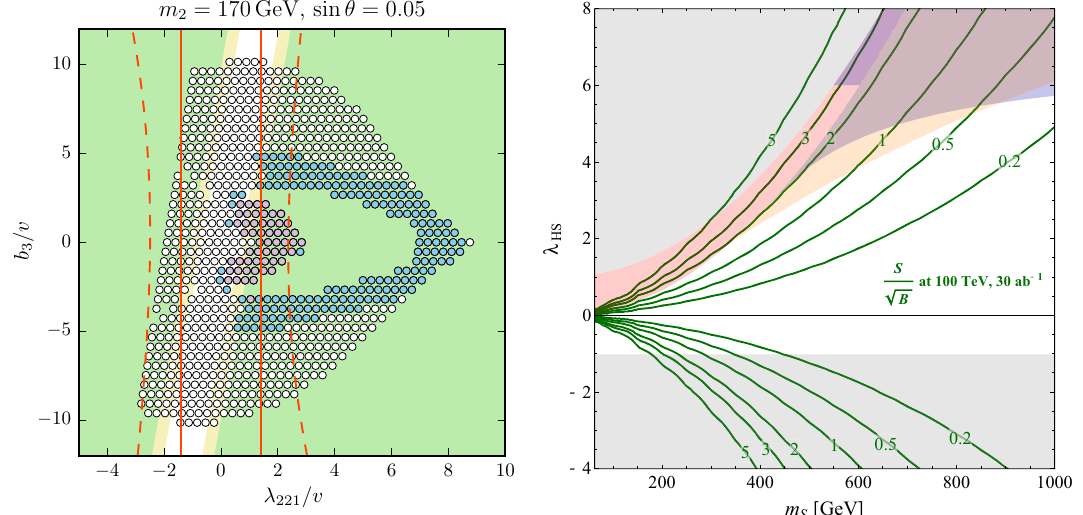
Fig. 11.2 Singlet-like scalar pair production as a signature of the EWPT in the xSM. Left: FCC-hh sensitivity to pp → h 2 h 2 → 2j3 (cid:13) 3 ν for a given h 2 mass and mixing angle. Here, λ 221 and b 3 are the h 2 h 2 h 1 and singlet cubic couplings, respectively. Darker (lighter) shadedregionsindicate5 σ (2 σ )sensitivityassuming30ab − 1 integrated luminosity. Coloured points feature a strong first-order EWPT. Also shownforcomparisonarethesensitivityprojectionsforh 1 self-coupling measurements(dashedcontours)andprecisionmeasurementsoftheZH